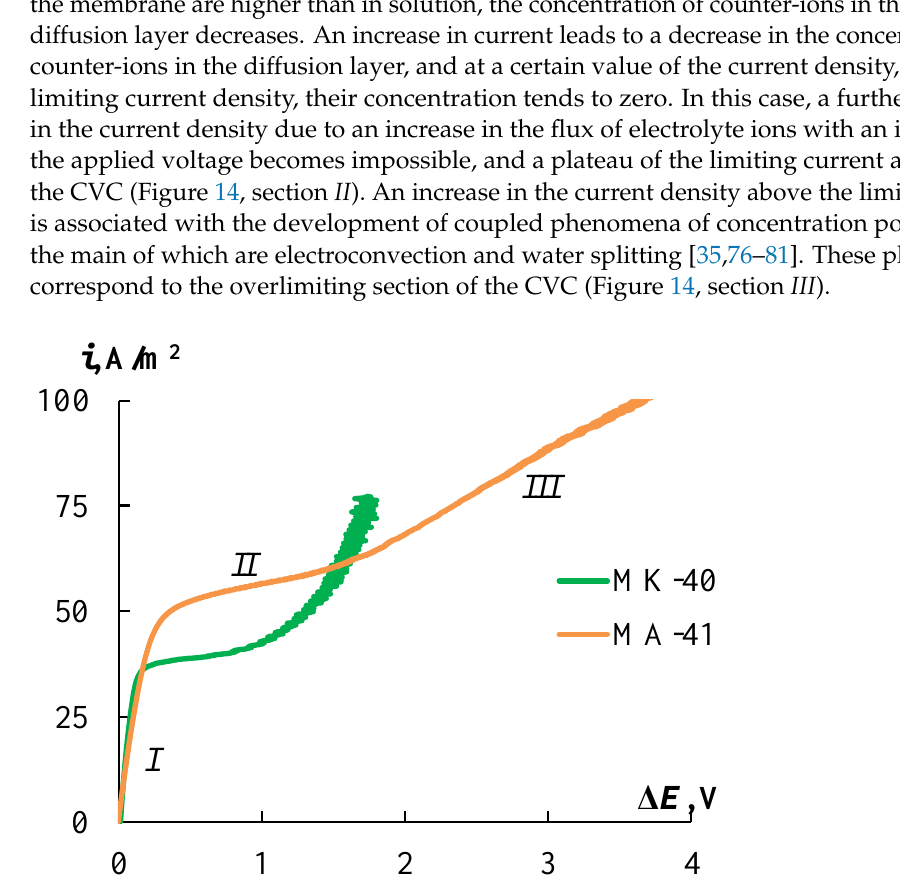
Figure 14. The CVCs of the initial MK-40 and MA-41 membranes in a 0.05 M NaCl solution: I —the ohmic section; II —the plateau of limiting current; III —the overlimiting region.